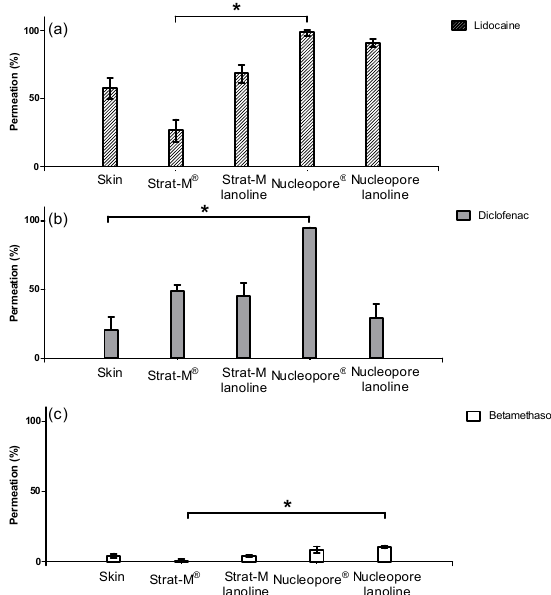
Figure 2. Normalized absorbed amounts (%) in skin, Strat-M ® , Strat-M-lanolin, Nucleopore ® , Nucleopore-lanolin for lidocaine ( a ), diclofenac sodium ( b ) and betamethasone dipropionate ( c ). * indicates a p -value ≤ 0.1 from the Kruskal–Wallis test.